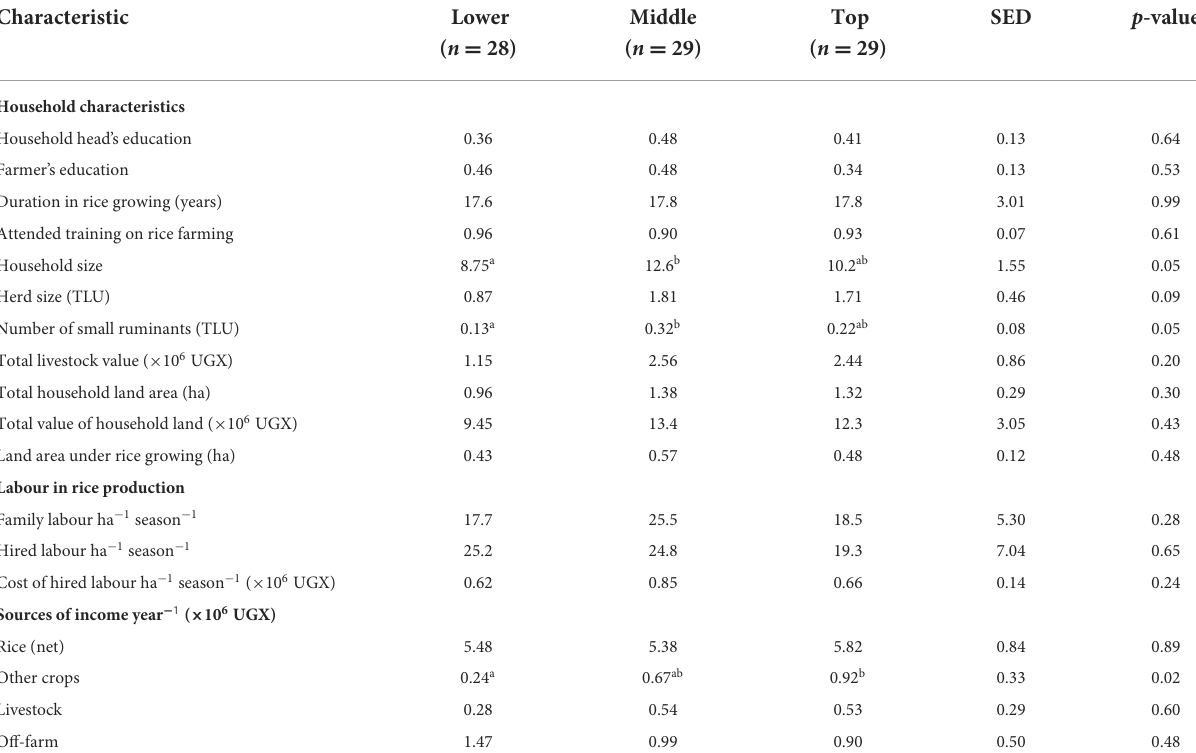
TABLE 4 Household socio-economic characteristics of lower-, middle- and top-yielding farmers, Doho rice irrigation scheme, Butaleja District, Uganda, 2021. Characteristic Lower